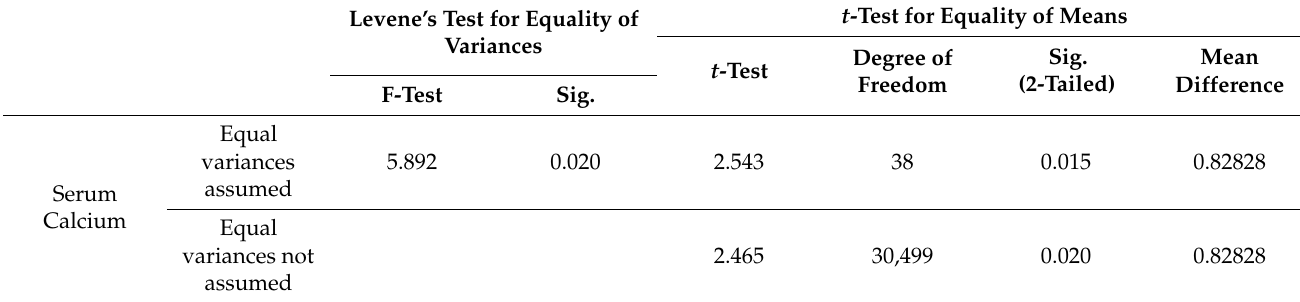
Table 4. Independent sample test for serum calcium according to